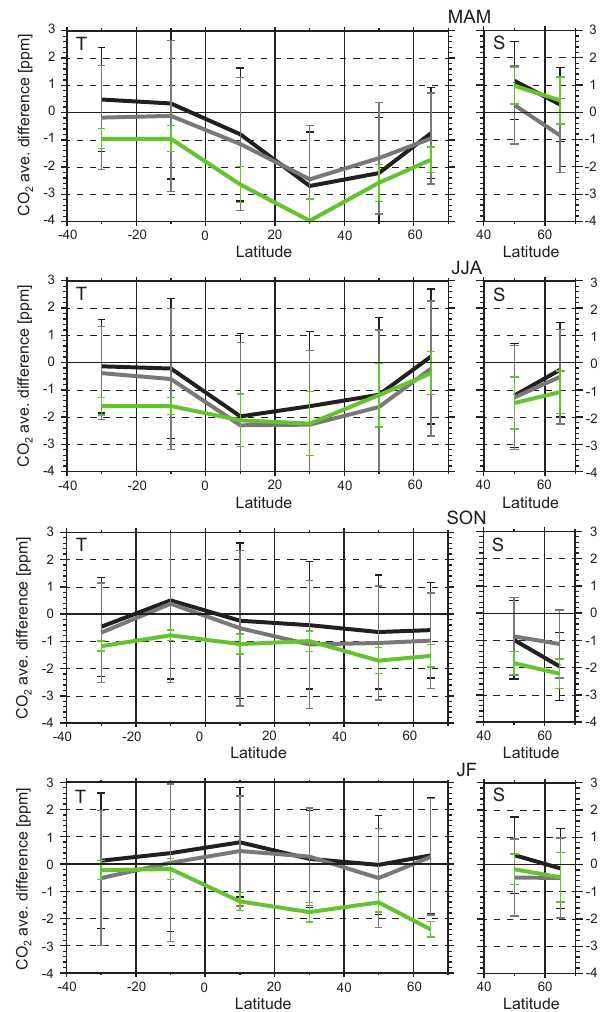
Figure 7. Differences between GOSAT/TANSO-FTS TIR and CONTRAIL (raw) averaged CO 2 data (TIR average minus CON- TRAIL (raw) average), TIR and CONTRAIL (AK) averaged CO 2 data (TIR average minus CONTRAIL (AK) average), and a priori (NIES TM 05) and CONTRAIL (raw) averaged CO 2 data (a priori average minus CONTRAIL (raw) average) for each season for each latitude band (40–20 ◦ S, 20–0 ◦ S, 0–20 ◦ N, 20–40 ◦ N, 40–60 ◦ N, 60–70 ◦ N), shown by black, gray, and green lines, respectively. Left and right panels show the differences in the upper troposphere and lower stratosphere, respectively. The 1 σ standard deviations of the latitudinal averages of TANSO-FTS TIR CO 2 data are shown by vertical